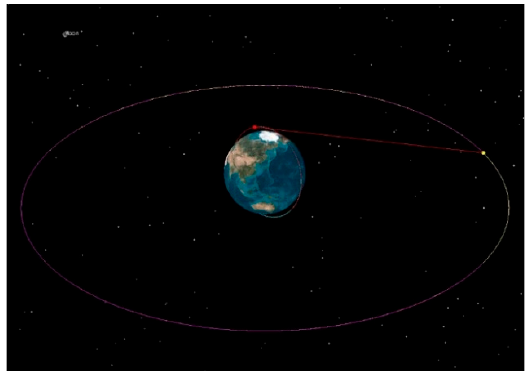
Figure 9. Schematic diagram of stk simulation scene.